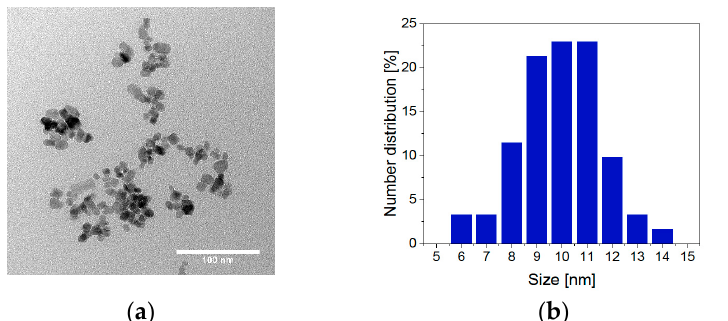
Figure 2. TEM microscopy: ( a ) image of BIONs and ( b ) number distribution of various particle diameters.